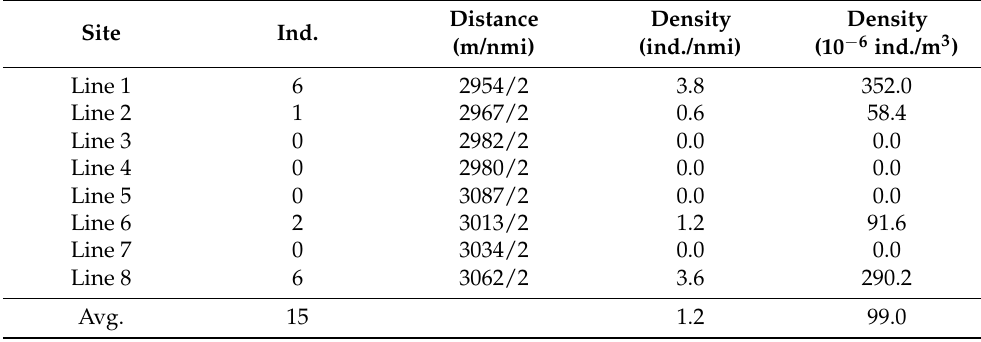
Table 14. Distribution density of jellyfish using the echo counting method in the Gijang coastal waters sea (7/23). Site